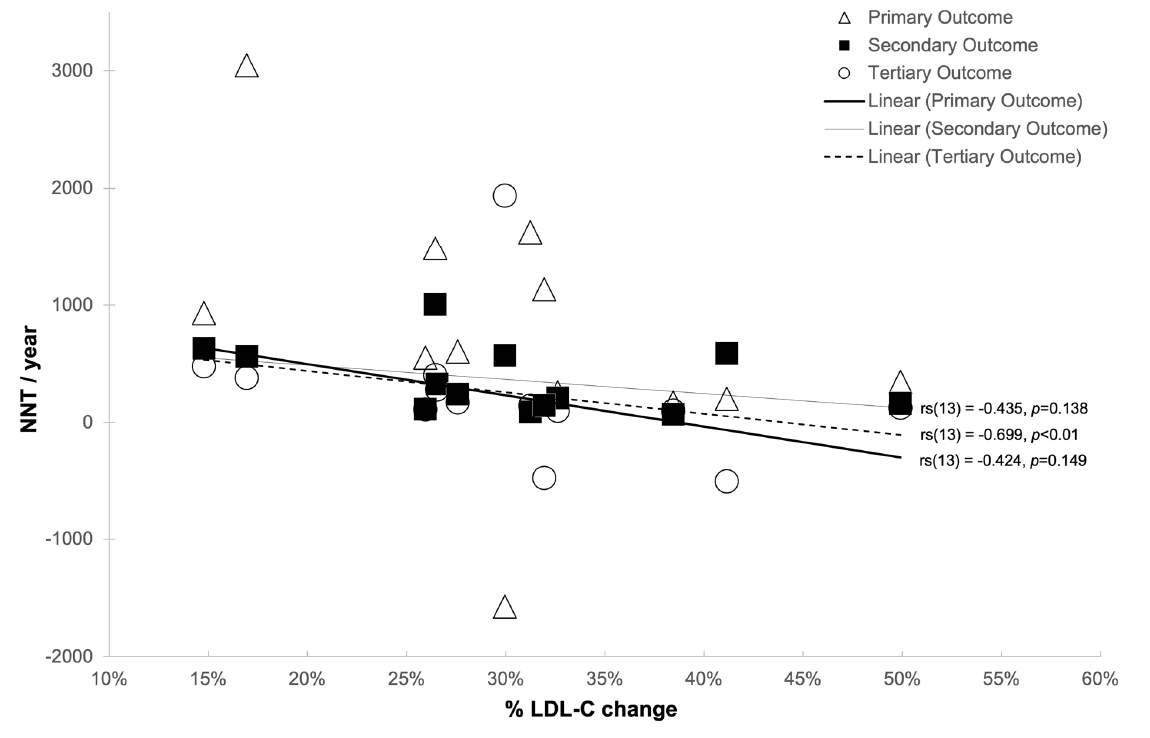
Figure 11. The relationship between LDL-C reduction % and number-needed-to-treat (NNT) / year.